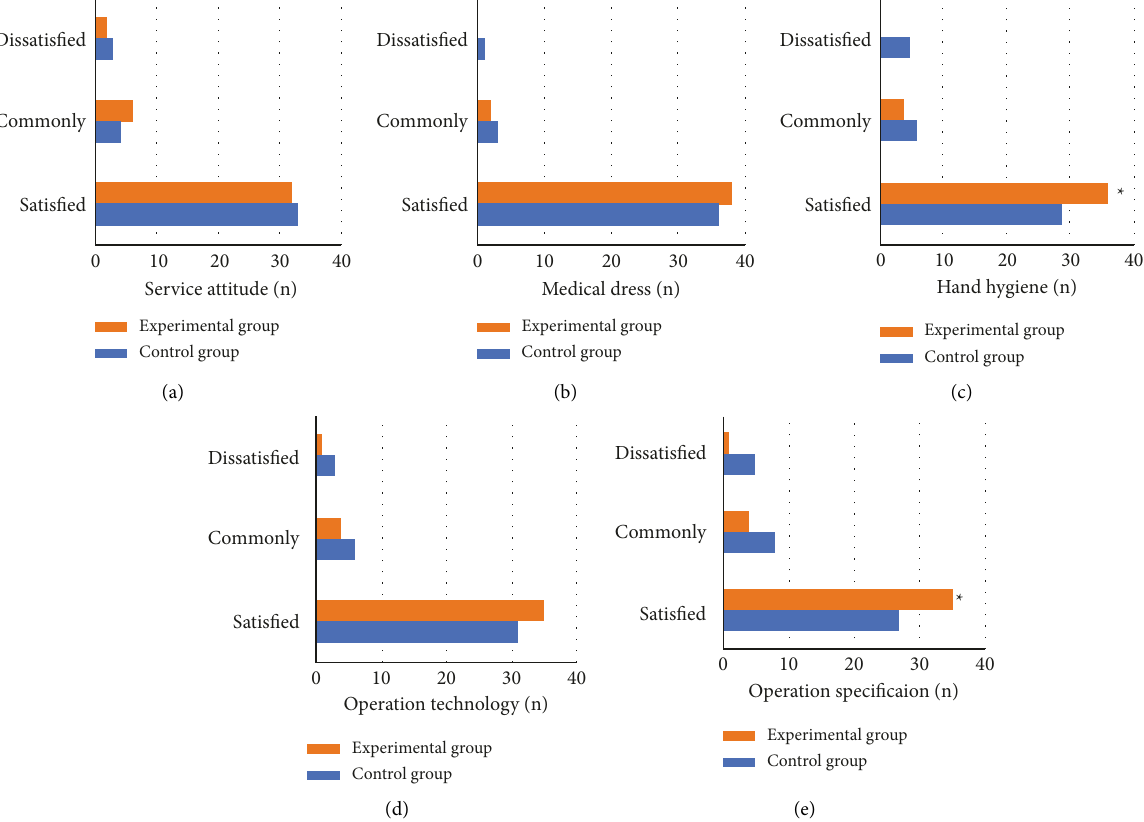
Figure 2: Results of patients’ satisfaction with nursing services. ( Note. ∗ represents a considerable difference vs. control group, P < 0 .